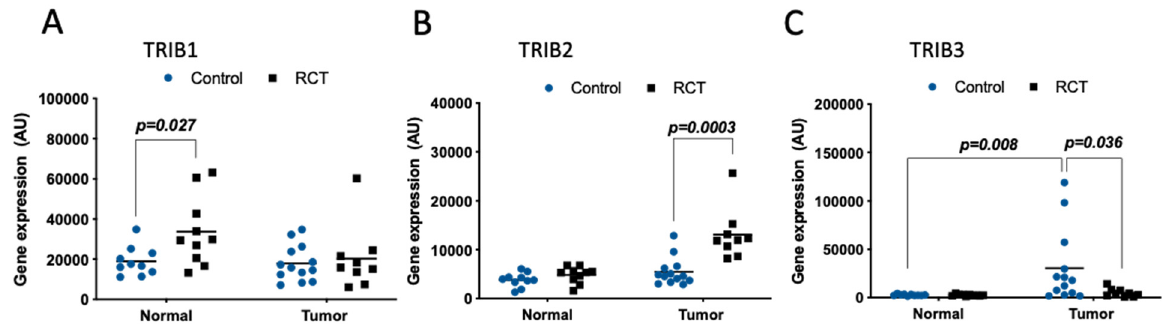
Figure 3. TRIB1 , TRIB2 , and TRIB3 gene expression in rectal adenocarcinoma samples. ( A – C ): Normal and tumor tissue specimens from patients with resectable adenocarcinoma of the rectum, before ( n = 10 Normal vs. n = 13 Tumor) and after ( n = 10 Normal vs. n = 9 Tumor) preoperative neoadjuvant radio-chemotherapy (RCT) treatment (GDS3756). Samples are plotted individually. TRIB1 (( A )—150749), TRIB2 (( B )—188922), and TRIB3 (( C )—113737) gene expression is represented as arbitrary units (AU). Independent unpaired two-tailed t test with Welch’s correction ( A ) or Mann–Whitney U test ( B , C ) were performed and only statistically significant changes (p < 0.05) between groups are denoted. The horizontal bars represent the mean of the values in each group.